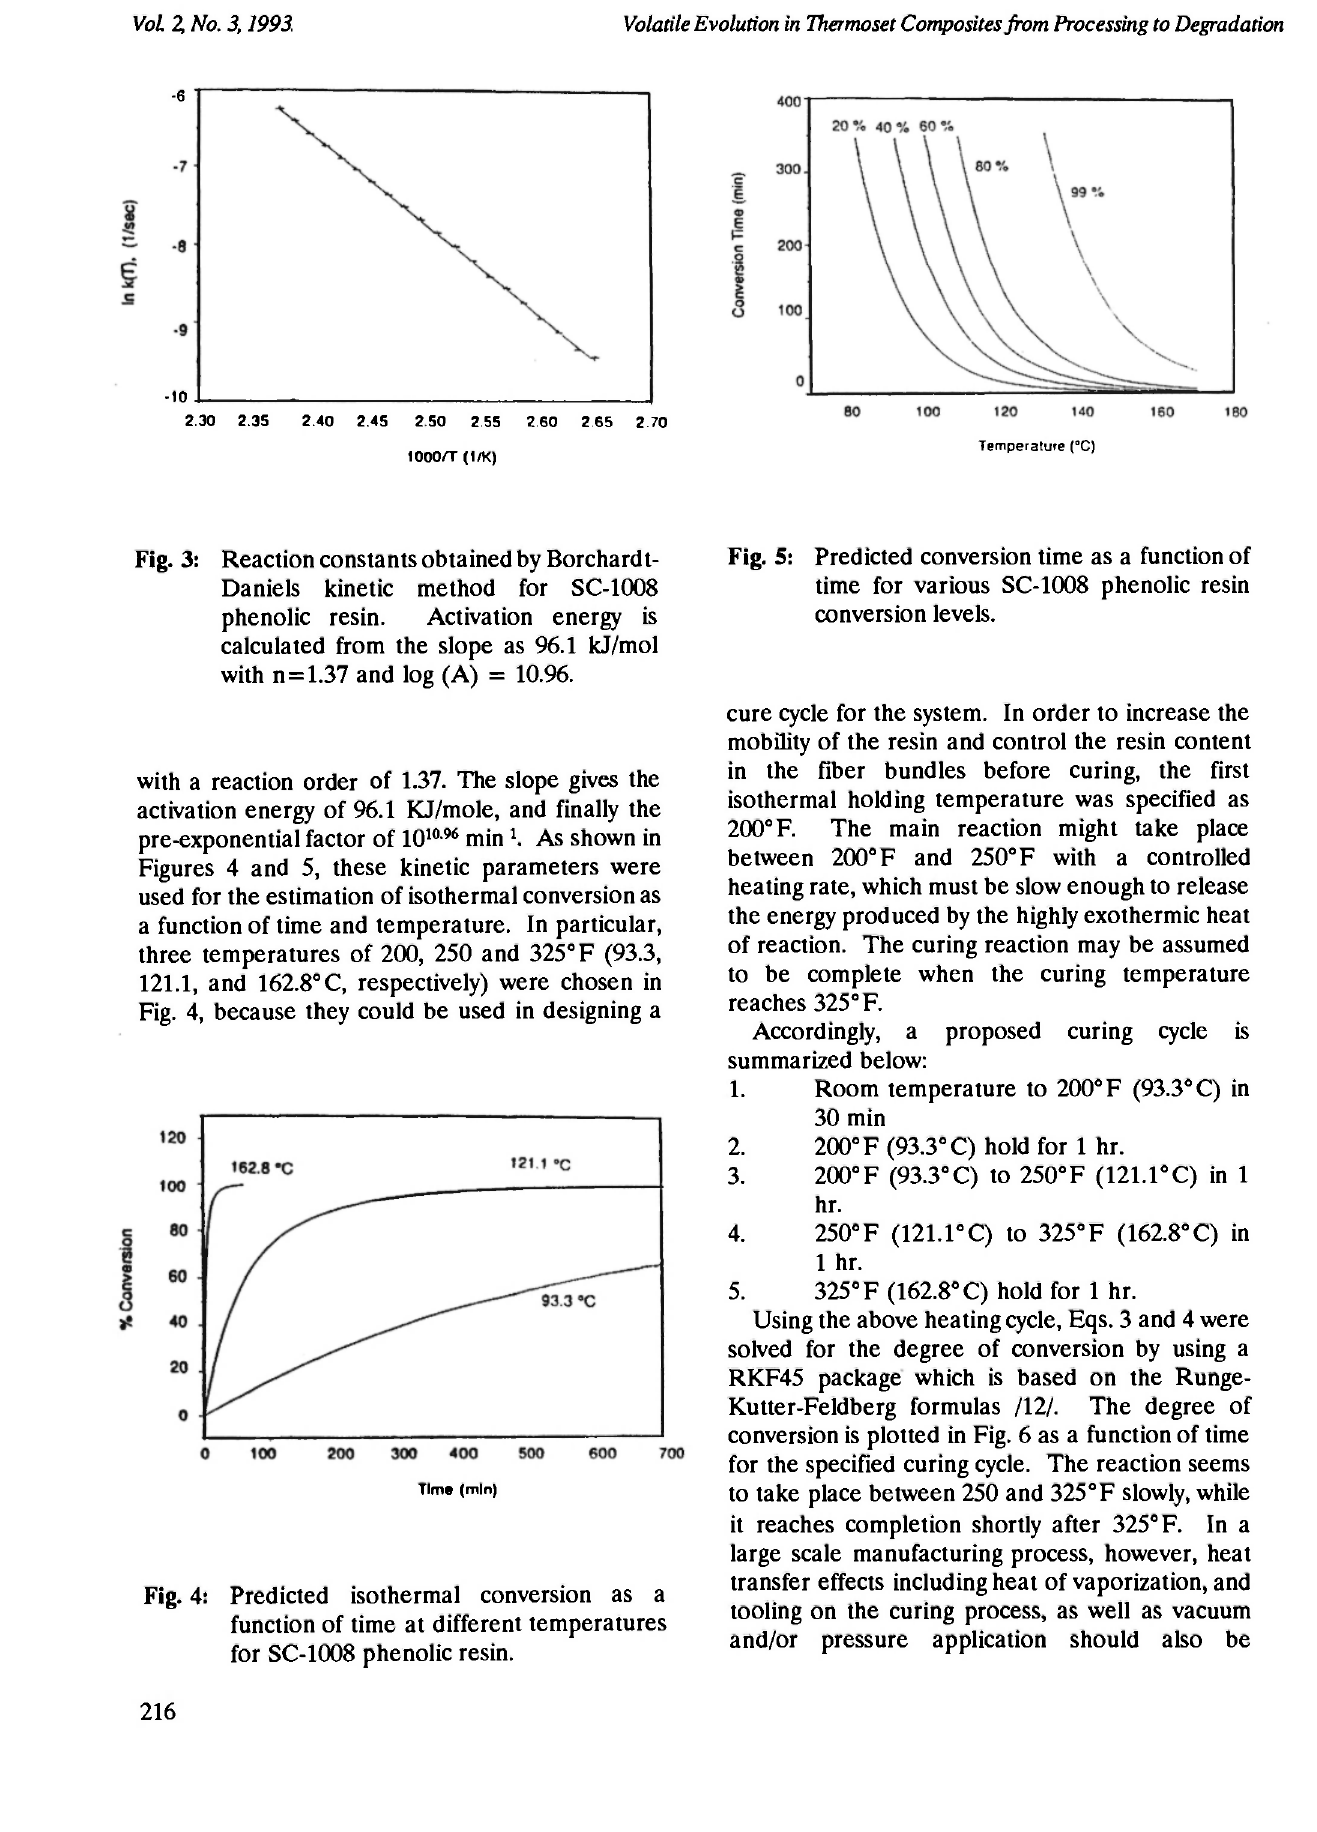
Fig. 5: Predicted conversion time as a function of time for various SC-1008 phenolic resin conversion